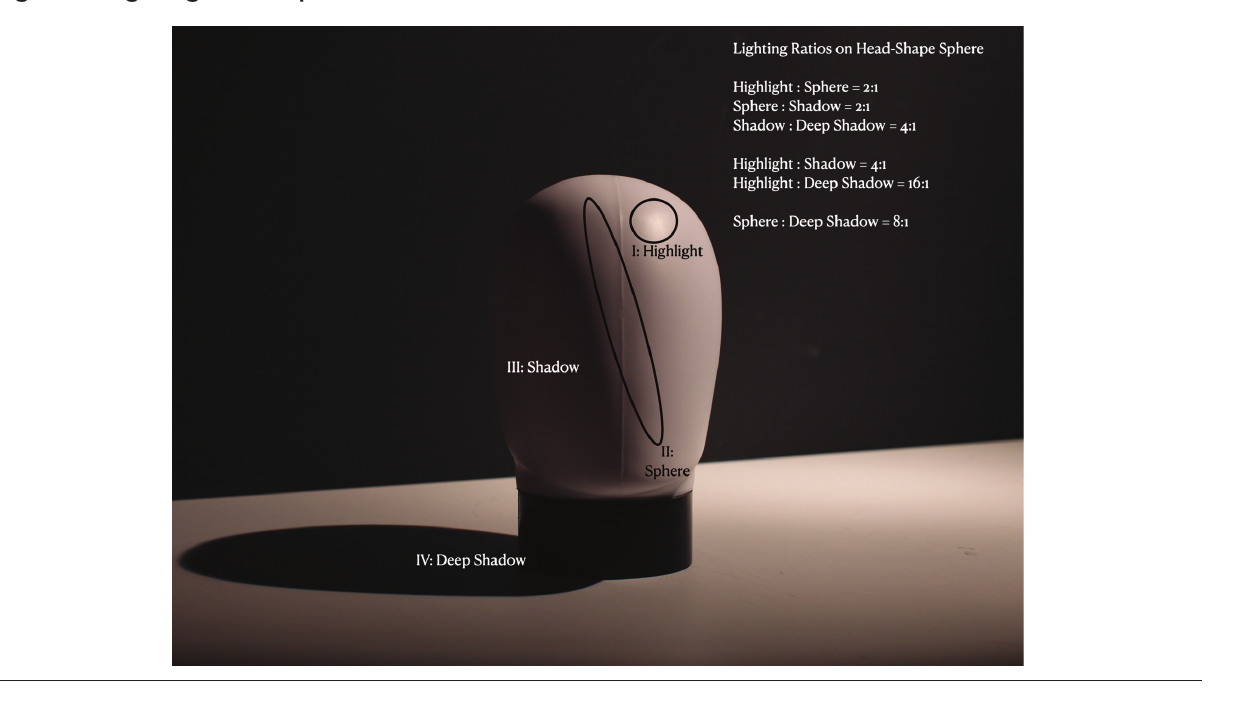
Figure 1. Lighting ratio explanation (Source: Author, 2022)